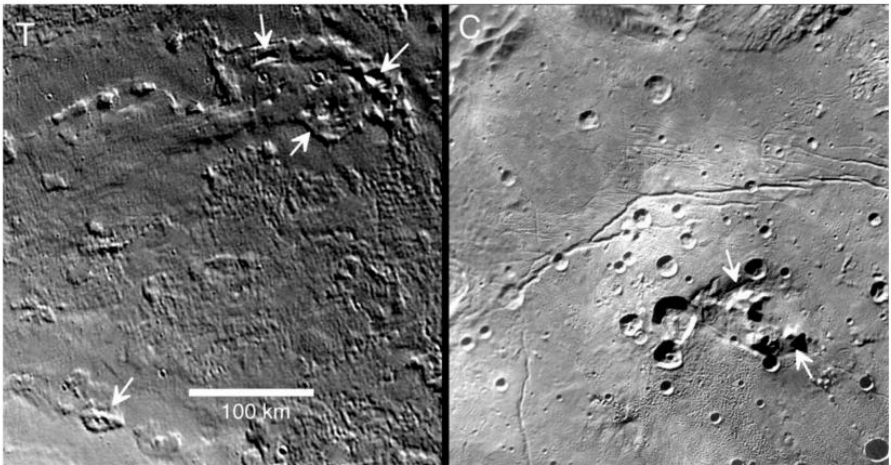
Figure 28. Knobs and moats around knobs and mountains on (T) Triton and (C) Charon ( right ). Knobs and possible moat on Triton are at upper right with a smaller example at lower left. Images shown to same scale (0.35 km/pixel); scene width ~300 km.